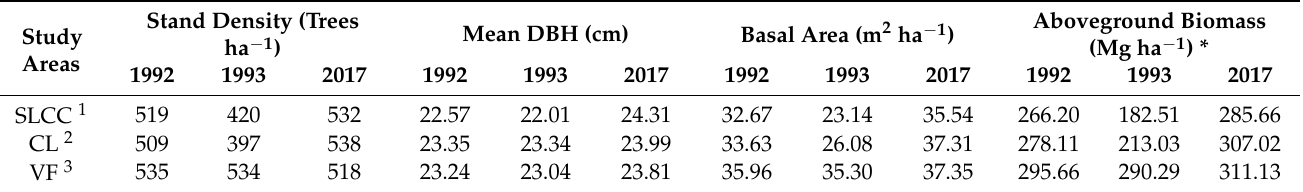
Table 1. The summary of stand characteristics in supervised logging with climber cutting plots, conventional logging plots, and virgin forest plots, before and after being